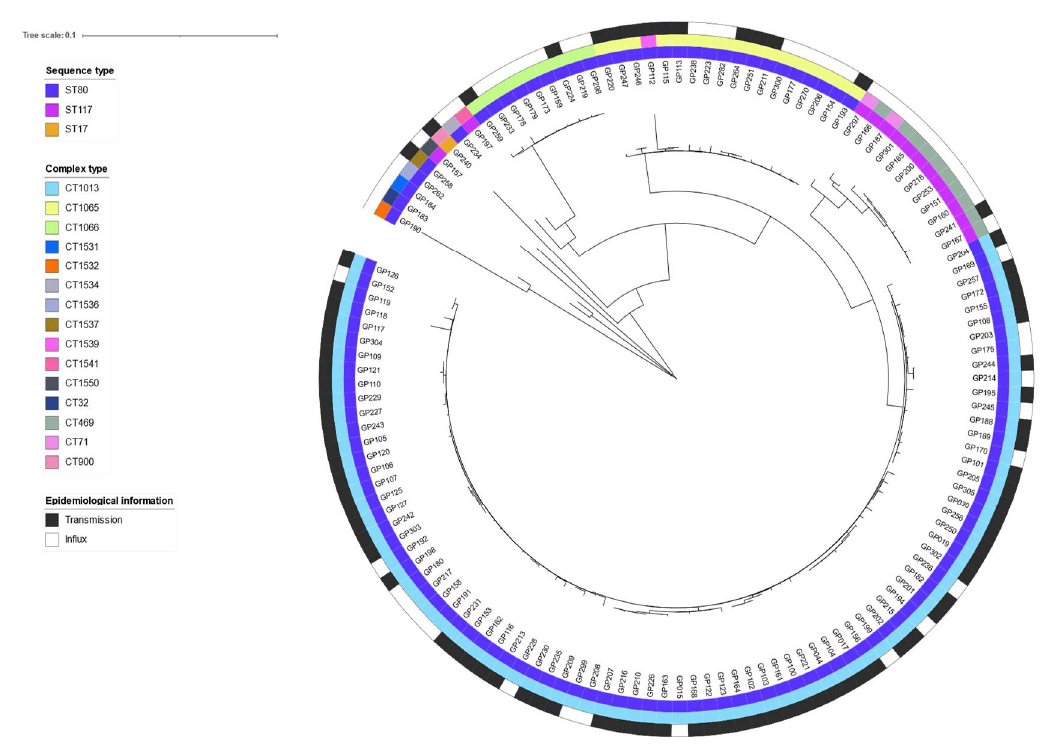
Figure 3. Differentiation between nosocomial transmission and VRE influx in an outbreak in two interconnected hospitals in Southern Germany, October 2015–November 2019. The neighbor joining tree based on Nei’s D A distance depicts the genetic relatedness of 134 isolates for which information on hospital-acquisition or VRE-positivity upon admission was available. The inner ring represents the sequence type (ST), the middle ring represents the complex type (CT), and the outer ring represents the epidemiological information on VRE transmission (black) and VRE influx (white). Tree visualization was realized by using the free online tool iTol v6 (https://itol.embl.de/, accessed on 30 June 2022).